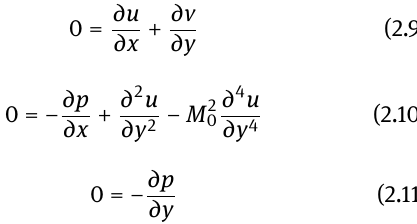
Fig. 1: The physical configuration of the problem